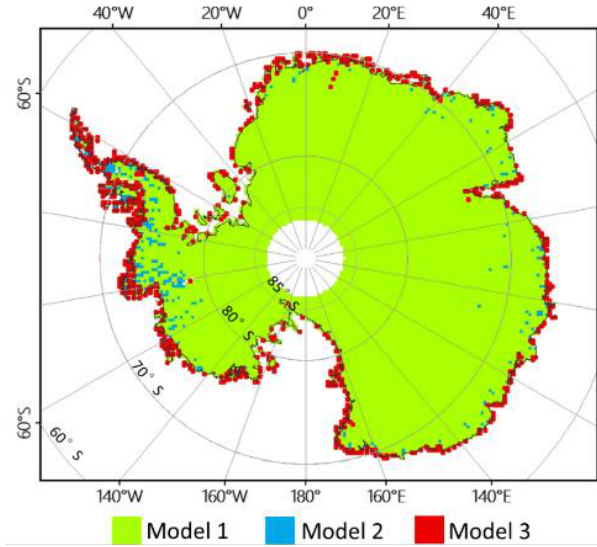
Figure 2. The distribution of the three models.